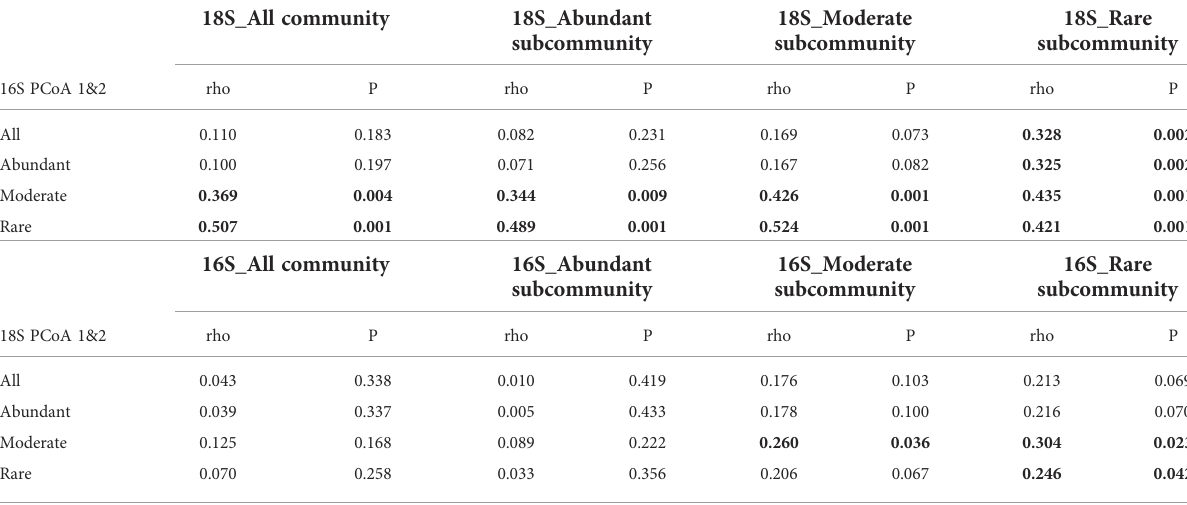
TABLE 1 Mantel tests showing the effects of cross-domain biotic factors on microeukaryotic and prokaryotic plankton communities. 18S_All community 18S_Abundant 18S_Moderate 18S_Rare subcommunity subcommunity